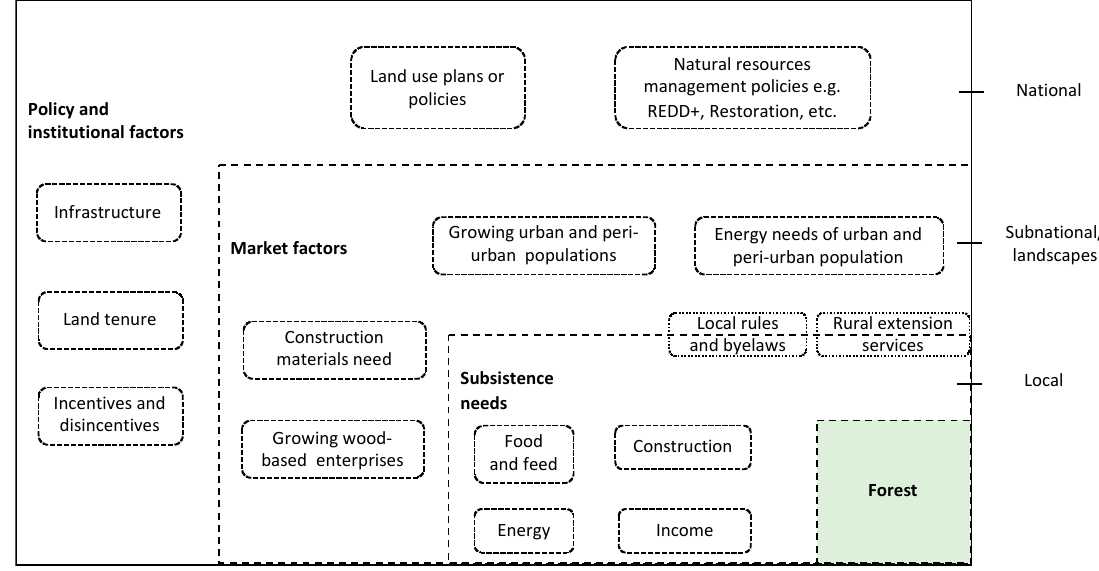
Figure 3. The relevant scale at which different drivers play strongly in influencing smallholder farmers decisions at local levels. Note: rural extension services and local rules and bylaws are relevant to both the subsistence needs and market forces.